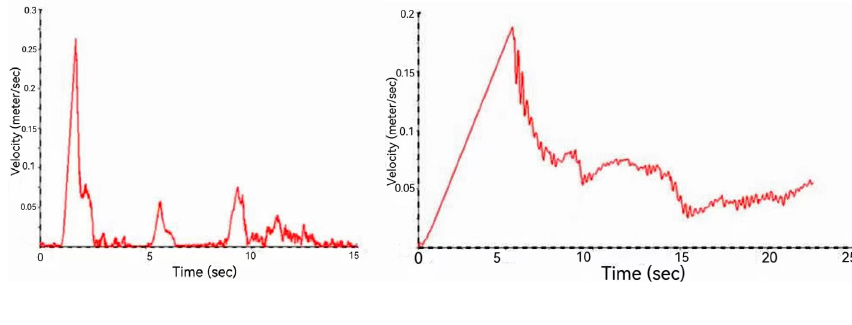
( a ) Two-section robot’s velocity. ( b ) Three-section robot’s velocity. Figure 11. Movement speed of the pipeline robots with different numbers of Figure 11 . Movement speed of the pipeline robots with di ff erent numbers of sections.